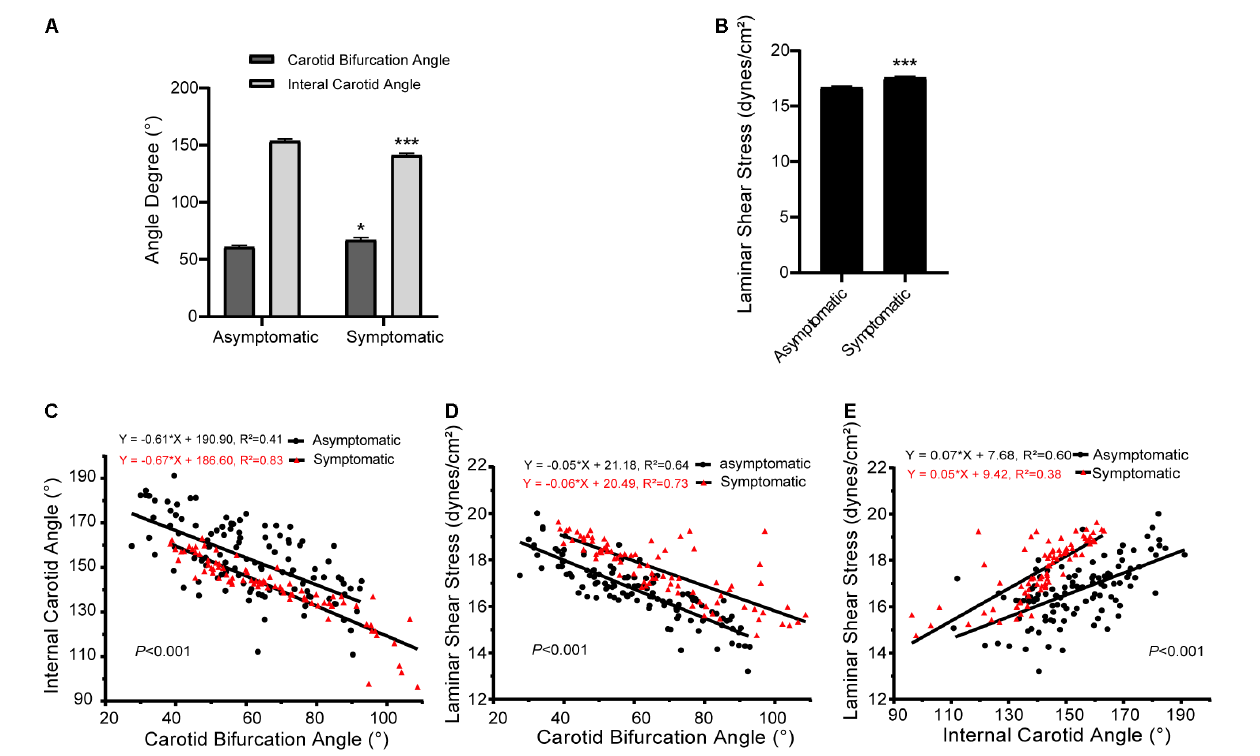
FIGURE 2 | Carotid bifurcation, internal carotid angle, and laminar shear stress in asymptomatic and symptomatic groups. (A) Comparison of carotid bifurcation angle and internal carotid angle. (B) Comparison of laminar shear stress. (C) Correlation of carotid bifurcation angle and internal carotid angle, interaction between asymptomatic and symptomatic groups. (D) Correlation of carotid bifurcation angle and laminar shear stress, interaction between asymptomatic and symptomatic groups. (E) Correlation of internal carotid angle and laminar shear stress, interaction between asymptomatic and symptomatic groups. Error bars represent standard error of mean (SEM). * P < 0.05, *** P < 0.001.